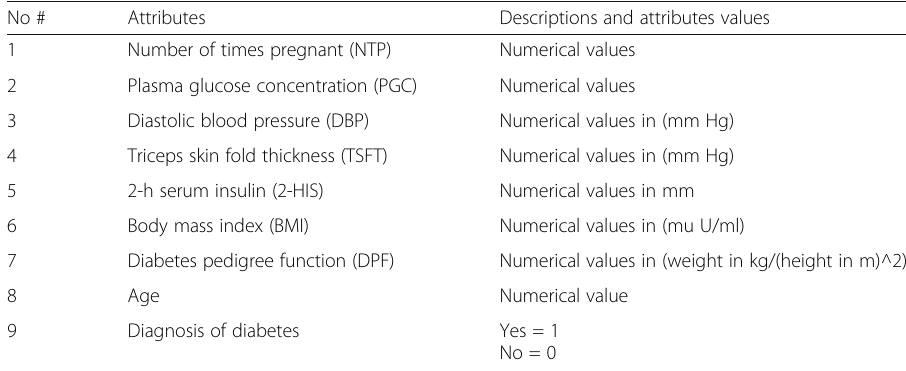
Table 1 Features of Pima Indians diabetes for diagnosing